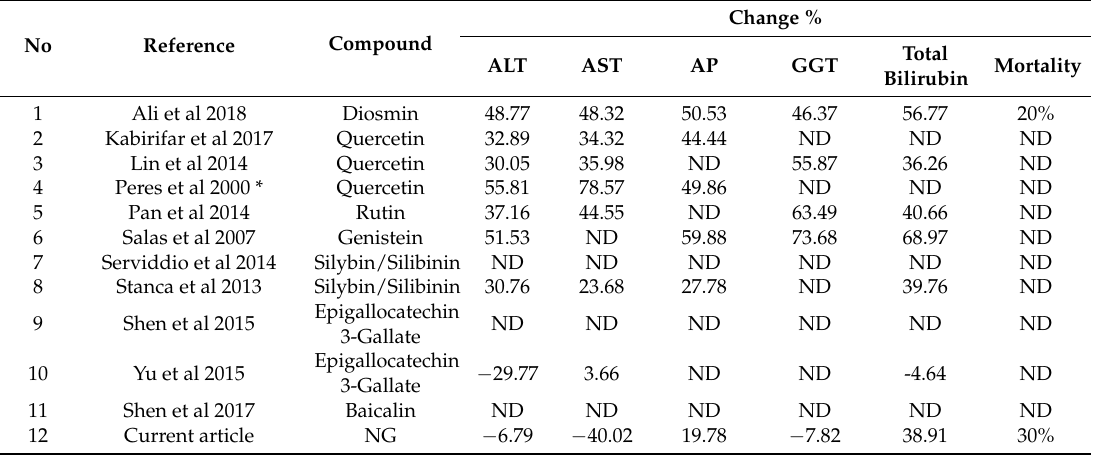
Table 2. Percentage changes of liver function parameters induced by flavonoids on BDL model.